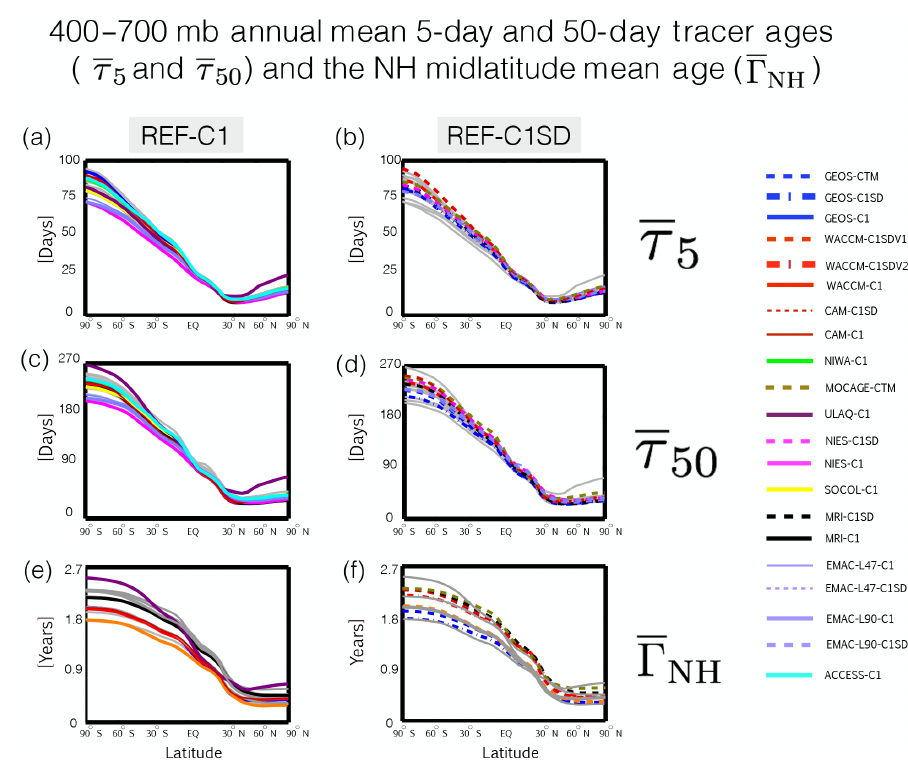
Figure 9. Meridional profiles of the annual mean 5-day loss and 50-day loss tracer ages, τ 5 (a, b) and τ 50 (c, d) , as well as the annually averaged mean transit time since air was last at the NH midlatitude surface (cid:48) NH (e, f) . Panels (a, c, e) and (b, d, f) show the tracer ages for the REF-C1 and REF-C1SD simulations, respectively. The grey lines denote the C1SD(C1) simulations in the left (right) panels in order to a provide a sense of the ensemble